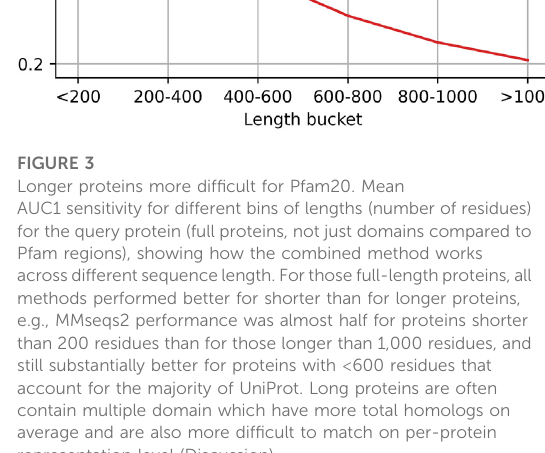
single domain-like Pfam regions). Instead of outperforming MMseqs2 (for CATH20), knnProtT5 performed clearly worse for Pfam20 (Figure 2: solid red and dotted green below solid blue; AUC1(knn,Pfam20) = 0.367 vs. AUC1 (Mmseqs2,Pfam20) = 0.52). While knnProtT5 and MMSeqs2 found a similar fraction of homologs in the fi rst 300 hits (68.0% vs. 67.4%), the vector distances (cosine similarity) between the per-protein